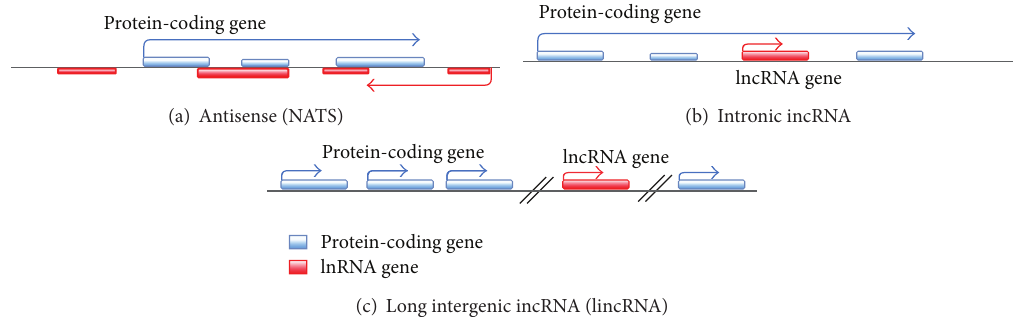
Figure 1: Classification and characterization of lncRNAs are based on their genomic localization with respect to the neighboring protein- coding gene. It is classified as overlapping lncRNAs including (a) natural antisense transcripts, or (b) intronic LncRNA and non-overlapping, (c) intergenic lncRNA; (lincRNAs), are transcribed from regions far away from protein-coding genes. The direction of arrow represents the different forms of transcription. Antisense lncRNA contains section of complementary sequences with the mature, spliced mRNA of the overlapping protein-coding gene. Intronic lncRNAs are transcribed within the intron of a protein-coding gene and therefore do not contain sequences complementary to the mature, spliced mRNA of the protein-coding gene